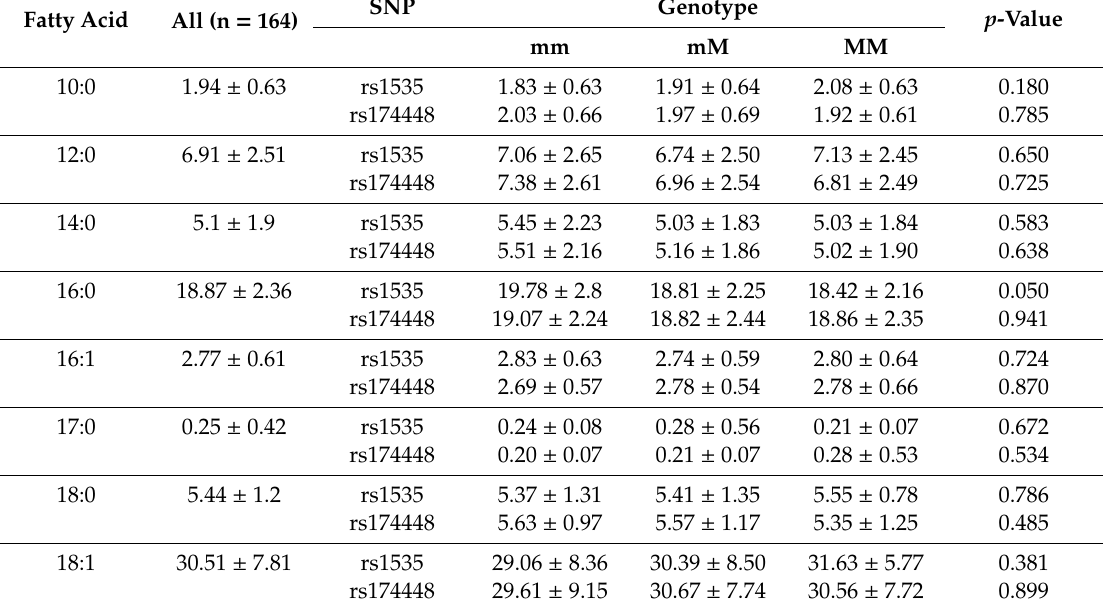
Table 3. Distributions of fatty acid compositions (percentage of total fatty acids identified) of human milk in study participants according to their genotypes 1,2